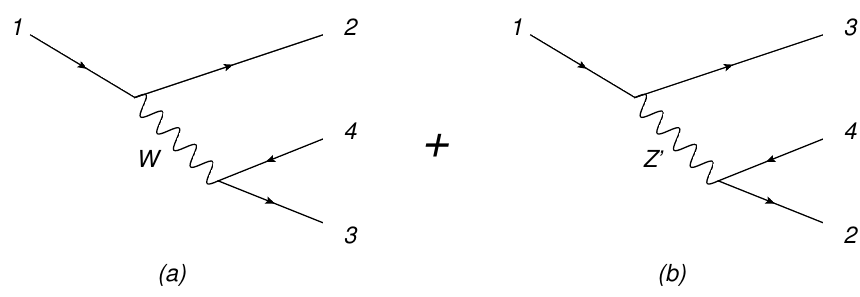
Figure 1 . W and Z’ exchange diagrams for the amplitude of a generic decay 1 ! 2 + 3 + 4. In the case of ‘standard’ muon decay we have 1 = (cid:22) (cid:0) ; 2 = (cid:23) (cid:22) ; 3 = e (cid:0) ; 4 = (cid:22) (cid:23) (cid:22) . In the case of LFV muon decay, 1 = (cid:22) (cid:0) ; 2 = e (cid:0) ; 3 = e (cid:0) ; 4 = e + ; in this case only the Z’ exchange diagram